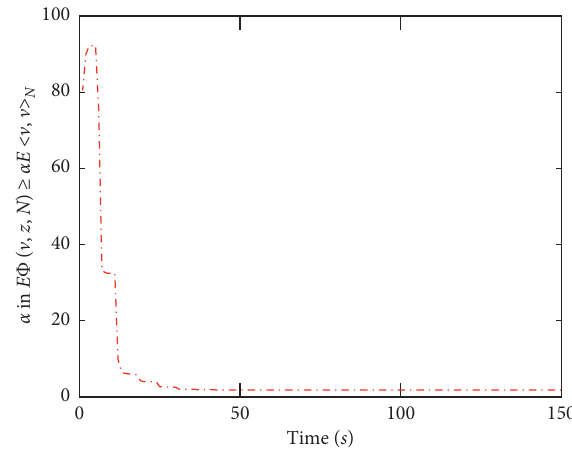
Figure 4: The variation curves of ϱ in E Φ ( v, z,N ){ } ≥ϱ E 〈 v, v 〉 closed-loop DTNSNSs (5) with time delay.